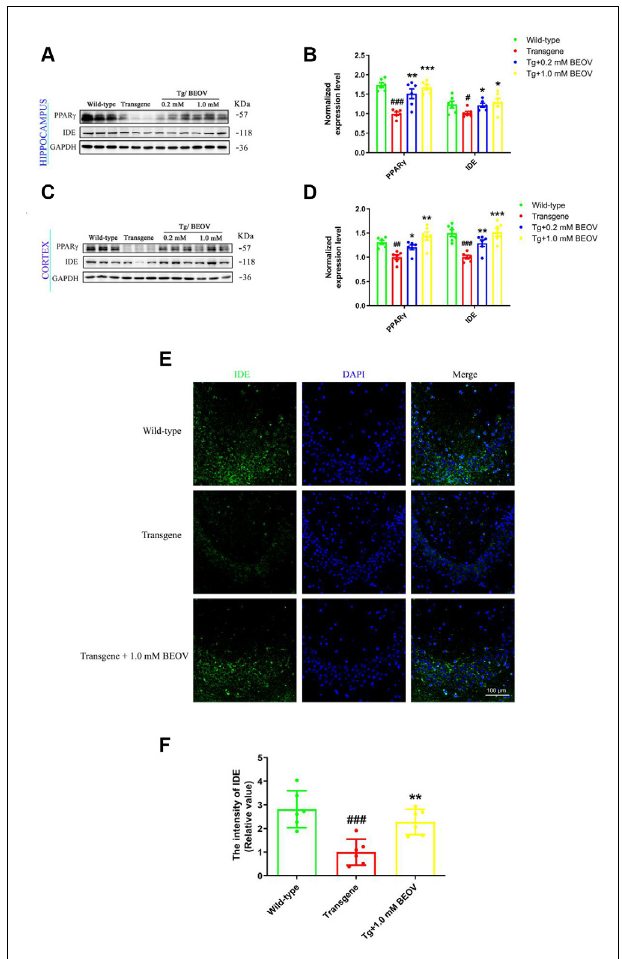
FIGURE 6 | BEOV up-regulated the expression of Peroxisome proliferator-activated receptor gamma (PPAR γ ) and insulin-degrading enzyme (IDE) in APPSwe/PS1dE9 mice. (A,C) Western blot analyses of PPAR γ and IDE levels in the hippocampus and cortex of WT, APPSwe/PS1dE9, and BEOV-treated APPSwe/PS1dE9 mice. (B,D) Semi-quantification of PPAR γ and IDE in the hippocampus and cortex of 9-month-old mice. Quantitative results were normalized against the levels of GAPDH. (E) Representative immunofluorescent images of IDE expression in the CA3 region of the hippocampus. (F) The staining intensity of IDE was quantified and six sections from different mice in each group were analyzed. Scale bar: 100 µ m. # WT group vs. AD group; *AD + BEOV group vs. AD group. n = 6, three females and three males; # P < 0.05, ## P < 0.01, ### P < 0.001, * P < 0.05, ** P < 0.01, and *** P < 0.001,